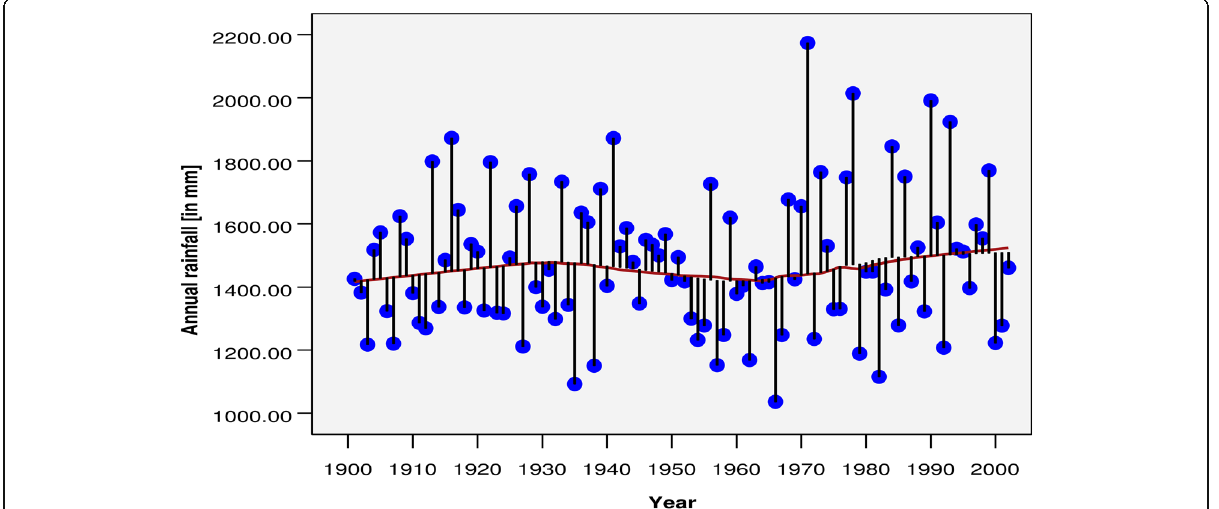
Fig. 12 Locally weighted regression (LOWESS) and scatter plots of the average annual rainfall in GWB for the period